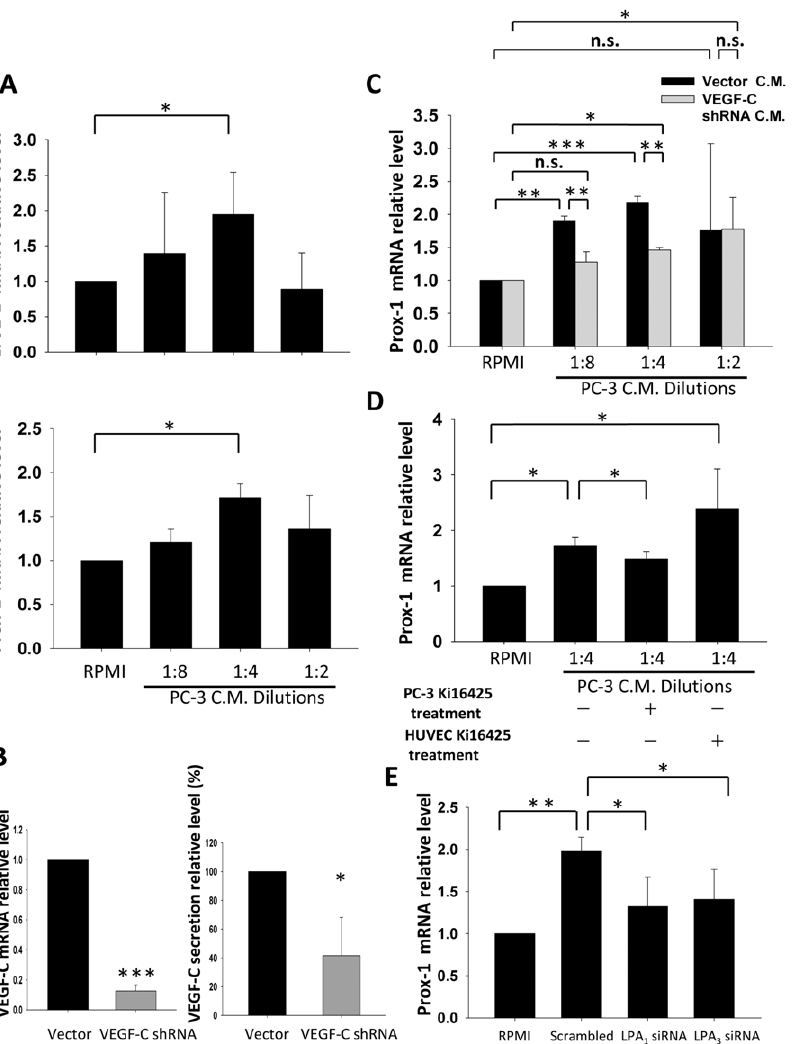
Figure 6. The role of LPA 1 and LPA 3 in PC-3 conditioned medium (CM) induced lymphatic marker expression. (A) PC-3 cells were cultured in RPMI-only medium for 24 h after 16 h of starvation. The 24 h CM was collected and diluted to treat HUVECs for 4 h. After treatment, HUVEC lymphatic marker expression was observed. (B) PC-3 cells stably transfected with VEGF-C shRNA were tested for VEGF-C mRNA and secretion expression. (C) VEGF-C knockdown PC-3 CM was used to treat HUVECs following the procedure described above. (D) PC-3 cells were treated with 10 m M Ki16425 while being cultured in RPMI-only medium for 24 h before CM was used to treat HUVECs. Ki16425 was also used to test whether LPA existing in PC-3 CM is crucial for HUVEC lymphatic marker regulation. Ki16425 (10 m M) was pretreated for 1 h before PC-3 CM treatment of HUVECs. (E) CM from PC-3 cells transfected with LPA 1 or LPA 3 siRNA was used to treat HUVEC cells as procedures described above. Sample mRNA was reverse- transcribed and analyzed by a real-time PCR. Relative levels of genes normalized to GAPDH and b -actin are shown. * Statistically different